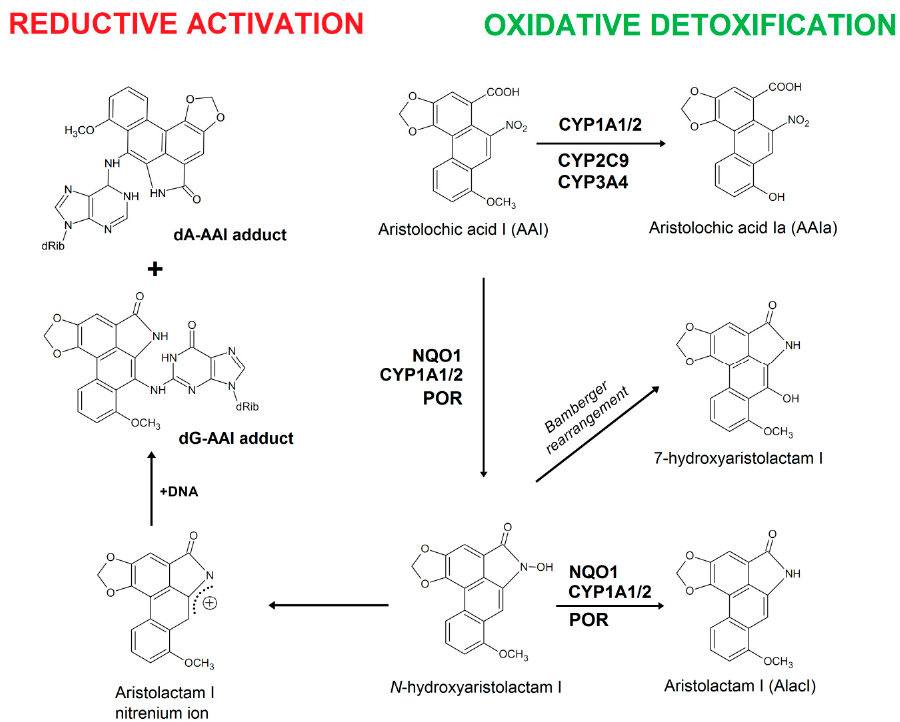
Figure 1. Activation and detoxification pathways of AAI. dA-AAI, 7-(deoxyadenosin- N 6 -yl) aristolactam I; dG-AAI, 7-(deoxyguanosin- N 2 -yl)aristolactam I; CYP1A1/2, cytochrome P450 1A1 and 1A2; CYP2C9, cytochrome P450 2C9; CYP3A4, cytochrome P450 3A4; NQO1, NAD(P)H:quinone